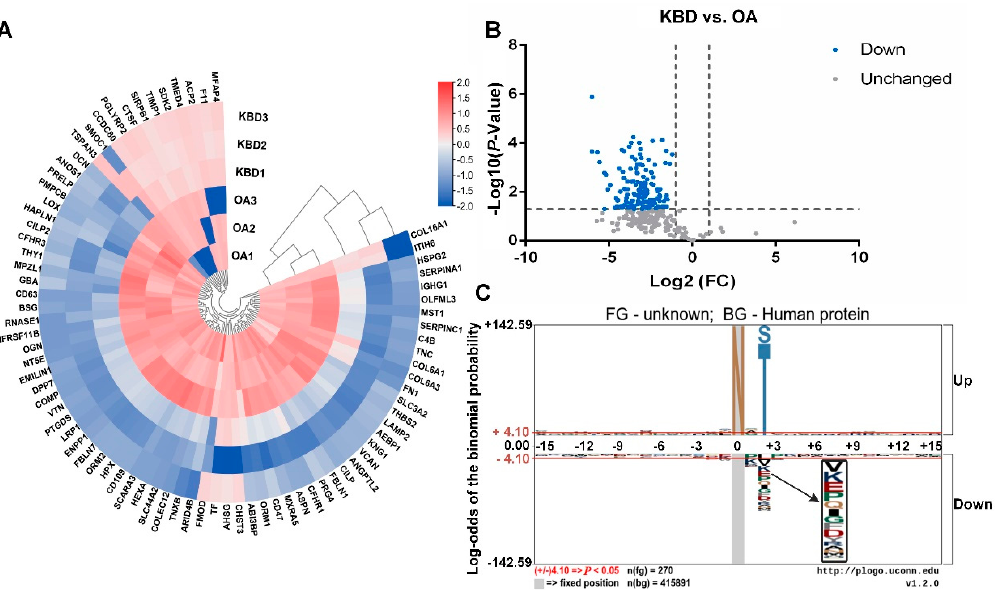
Figure 4. Heatmap, volcanic plot, and motif analysis in KBD vs. OA. ( A ) Heatmap of differentially expressed N-glycoproteins of knee cartilage in KBD vs. OA. Circular heatmap obviously classified samples into two distinct groups by clustering analysis. The comparative analysis aimed to determine whether significant differences could be found in KBD vs. OA. Within KBD1, KBD2, KBD3, and OA1, OA2, OA3, respectively, the differences were small. The overall difference in OA vs. KBD was significant. ( B ) Differential expression of N-glycopeptides from knee cartilage in KBD vs. OA. N-glycopeptides with fold-change (FC) ≥ 2.0 and p < 0.05 were considered as up-regulated N-glycopeptides, and those with FC ≤ 0.5 and p < 0.05 as down-regulated N-glycopeptides. Significantly, modification sites in KBD vs. OA. Plogo-generated relative frequency plots of the significant sequence motif. It is reliable when the heights of amino acid residues are above 4.10 (that is to say when p < 0.05, the results are